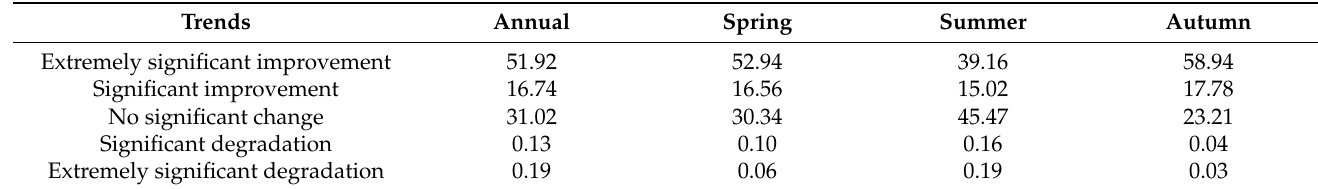
Table 2. Variation trend and significance of vegetation NDVI in Ordos